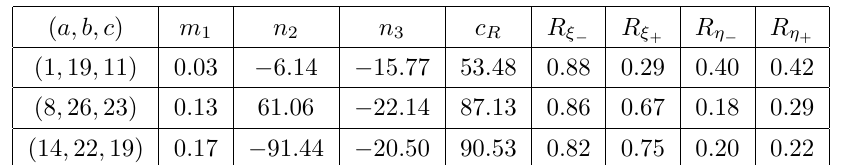
Table 4 . Values of m 1 ; n 2 and n 3 (divided by g (cid:0) 1), c geo R-charges (divided by N ) for certain triples a; b; c with positive a and (cid:20) = (cid:0) 1. Observe that the central charges and R-charges are all